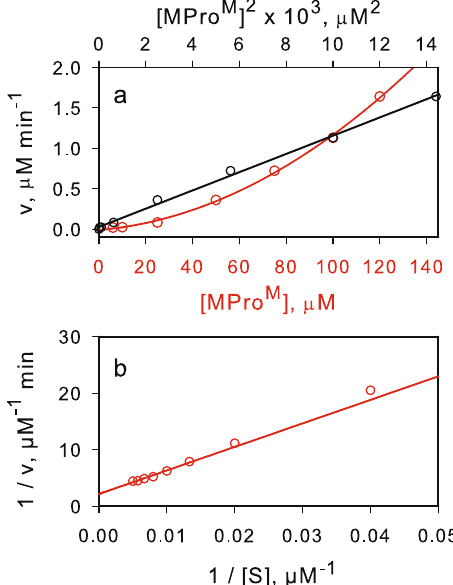
Fig. 3 Evaluation of the catalytic ef fi ciency of MPro M . a Non-linear relationship between the rate of catalyzed hydrolysis vs the protein concentration (red line), and the linear relationship between the rate of catalyzed hydrolysis vs the square of the protein concentration (black line). b Lineweaver-Burk plot for the catalyzed hydrolysis at a concentration of 40 µ M MPro M